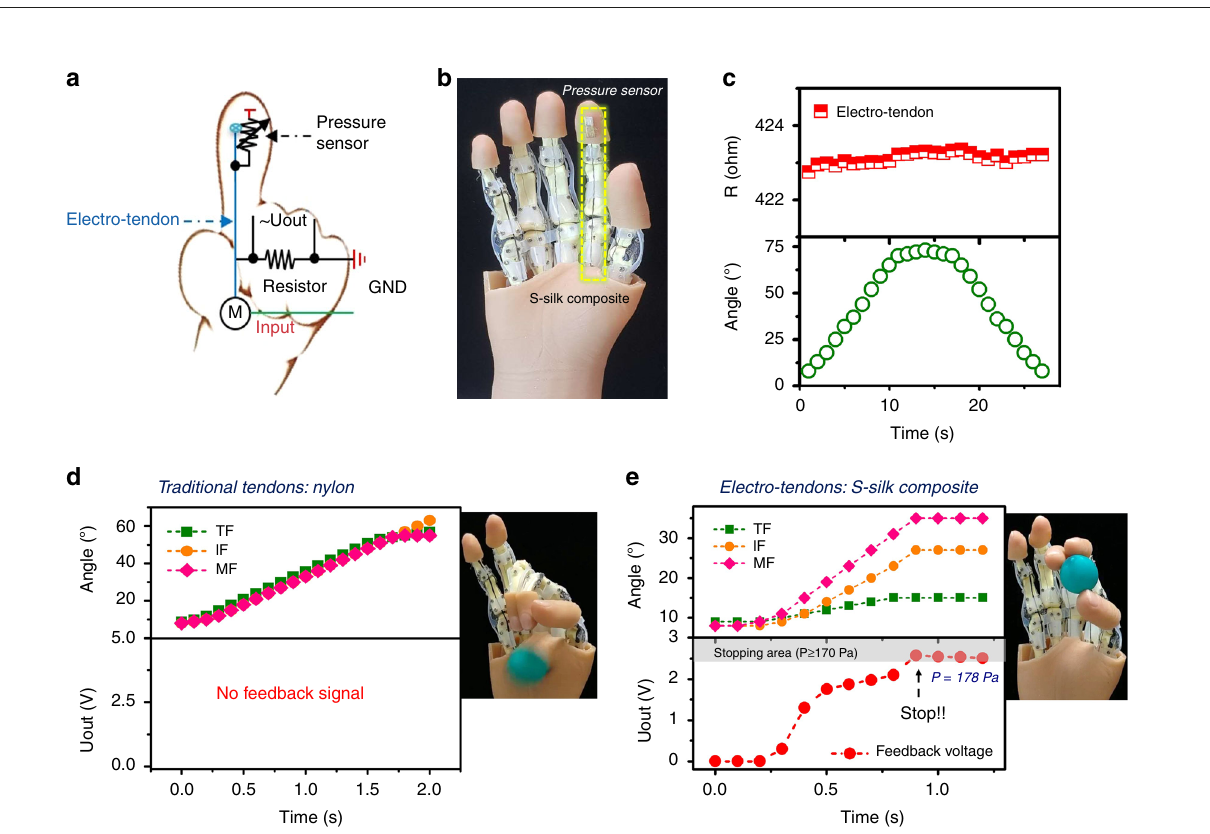
Fig. 3 Performance of humanoid robotic hands assembled with S-silk composite as electro-tendon. a Photograph of a 3D-printed robotic fi nger with an S-silk composite@10% SWCNT electro-tendon held in place by a silicone-based extensor. b Photograph showing the index fi nger at resting state has an angle of about 8°. c Photograph of the fi nger bent to the maximum position, pulled by the tendon. d Graphs show the bending angle (red curve) of the robotic fi nger correlates with the change in length (black curve) of the electro-tendon. The angle at maximum bending is 73° (peak of the red curve). This whole process has taken ~1.5 s. e Cyclic bending tests of robotic fi ngers assembled using different materials as the tendon show tougher materials were more durable. Our S-silk@10% SWCNT could withstand ~40,000 cycles of the full bending process, nearly double that of fi ngers using natural S-silk and nylon fi ber. Because of low toughness, fi ngers using steel fi ber and PDMS fi ber failed to complete a full bending process. The error bars of e show standard deviations based on 10 independent samples. f Graph shows the endurance of the fi nger using S-silk composite @10% SWCNT. g , h Lifting weight of humanoid robotic fi nger using different types of fi bers (diameter of all fi ber is 0.3 mm). S-silk composite@10%SWCNT loaded about 7.6 kg, which was comparable to steel fi ber. The error bars of h show standard deviations based on 10 independent samples.